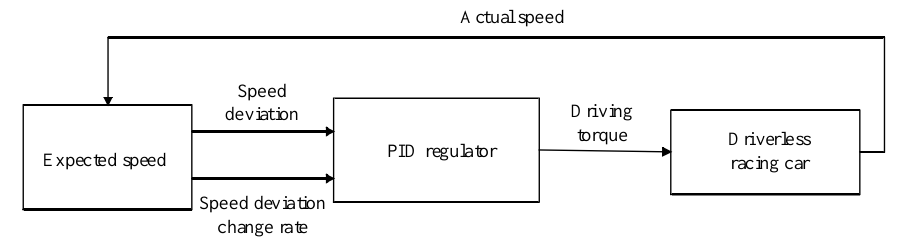
Figure 4. Incremental PID longitudinal control of the racing car.